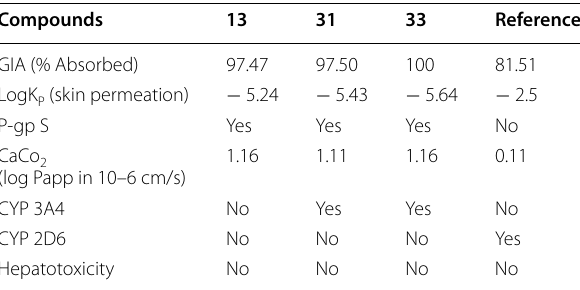
Table 9 Predicted ADME properties of designed inhibitors